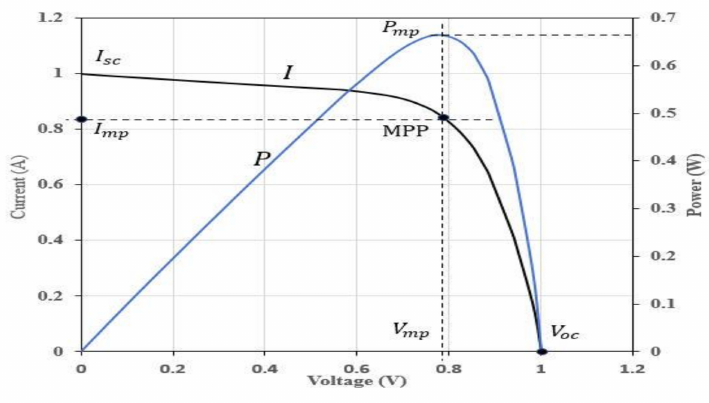
Figure 1. Normalised experimental current–voltage (I–V) and power–voltage (P–V) characteristics of a generic PV generator.